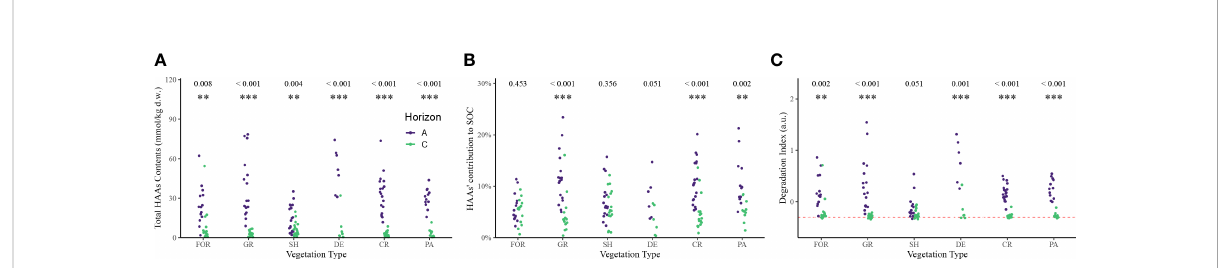
FIGURE 2 Signi fi cant differences in the content of HAAs (A) , their contribution to organic carbon (B) and the degradation index (C) between A-horizon and C-horizon across continental United States. FOR, evergreen or mixed forest; GR, grassland/herbaeous; SH, shrubland; DE,decidous forest; CR, small grains or crop; PA, pasture/hay. Samples from fallow or low intensity residential are not shown here due to the small sample size. Different colors represent different soil horizons. The numbers and marks at the top represent the results and signi fi cance of the t-test. Red dashed line in the C-sub fi gure is the reference line indicating the stability of DI in the C-horizon. **0.001< p <0.01;